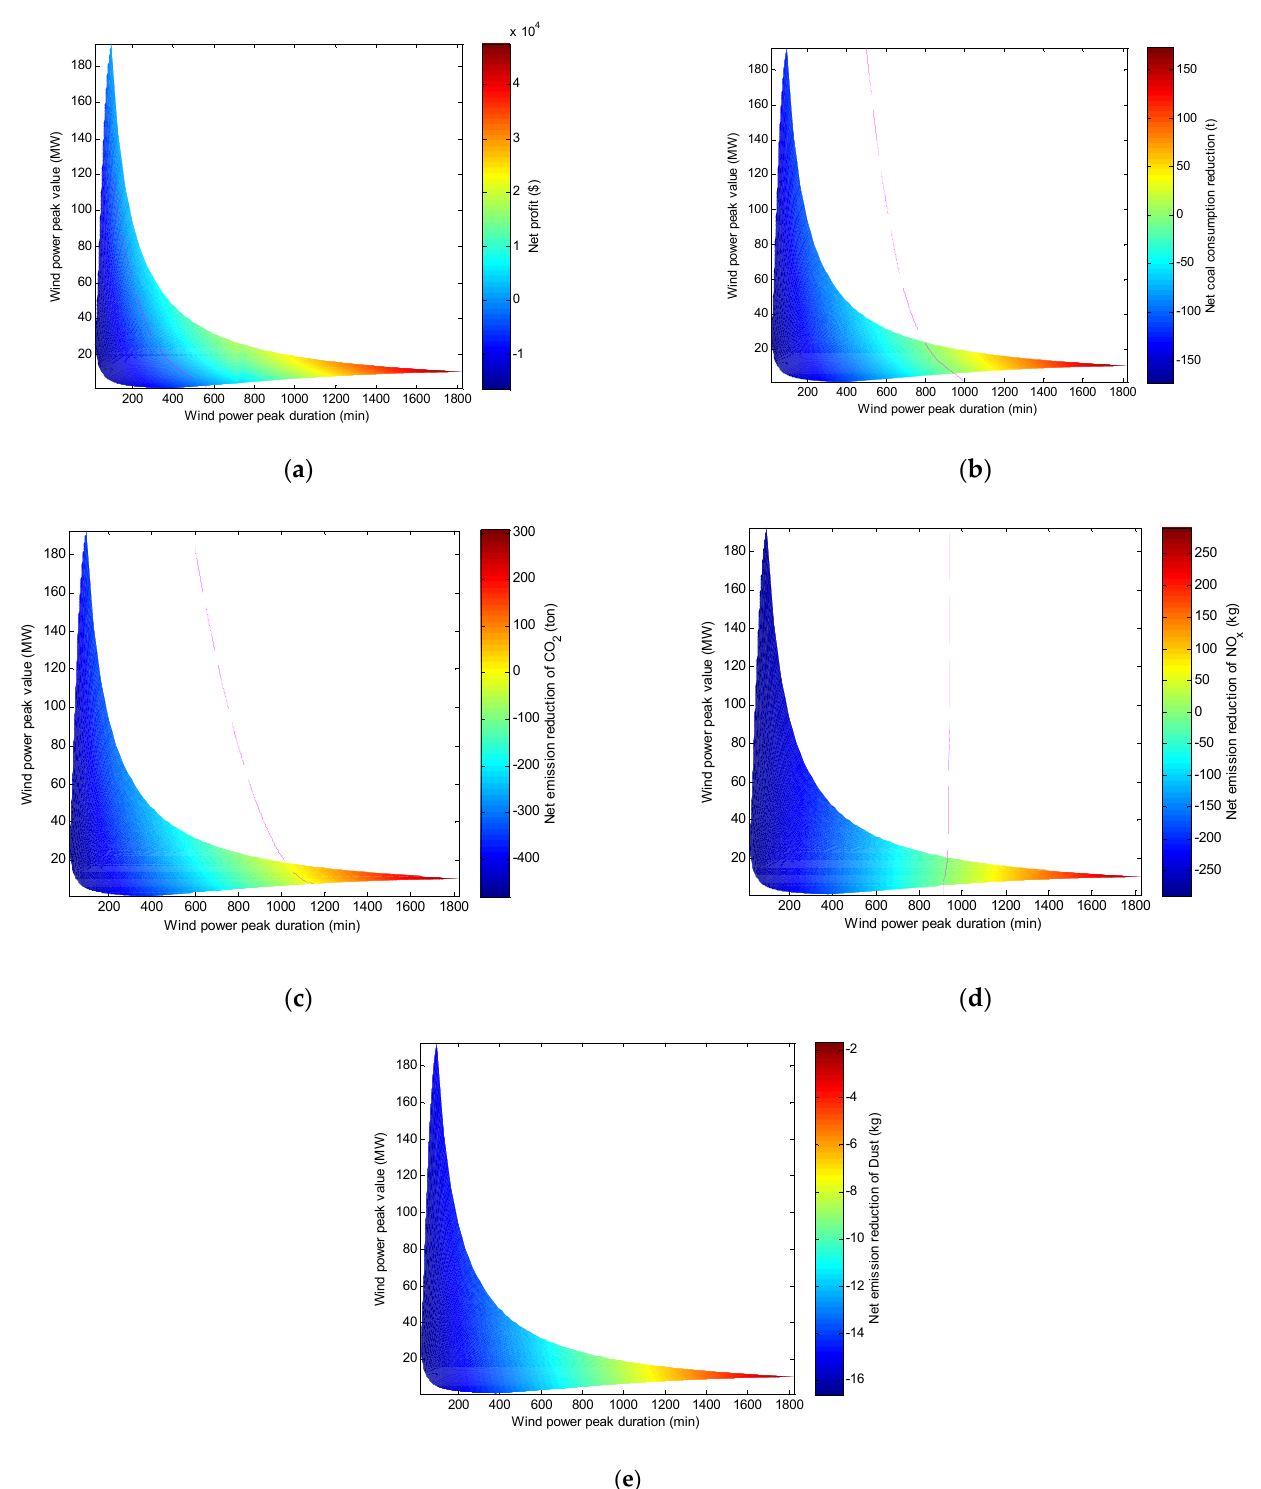
Figure 6. Net profit and net emission reduction of the wind–coal combined power generation system of strategy (2) against wind energy curtailment for wind power peaks above 540 MW. ( a ) Net profit; ( b ) Net coal consumption reduction; ( c ) Net emission reduction of CO 2 ; ( d ) Net emission reduction of NO x ; ( e ) Net emission reduction of dust. In Figure 6a, the dotted line is the wind energy curtailment boundary, in which the net benefit is the decision indicator. The boundary line is generated by fitting some( T , H ) points with approximately zero net profit, and wind energy of wind power peak should be curtailed in the lower left of the boundary line. Four representative points on the boundary line were selected, and the corresponding wind power peak duration, peak height, power generation, and the power generation costs with different strategies are shown in Table 3. Table 3. Wind energy curtailment boundary with net income as the decision target. Boundary Points 0.6811 The dotted line in Figure 6b is the wind energy curtailment boundary line with the net coal saving amount as the decision index. The boundary line is generated by the fitting of some ( T , H ) points corresponding to the net coal saving amount at approximately zero. The wind power peaks ( T , H ) corresponding to the points in the lower left area of the corresponding boundary line should be abandoned. Four representative points on the boundary line were selected, and the corresponding wind power peak duration, peak height, power generation, and the system power generation coal consumption corre ‐ sponding to two different strategies are shown in Table 4.